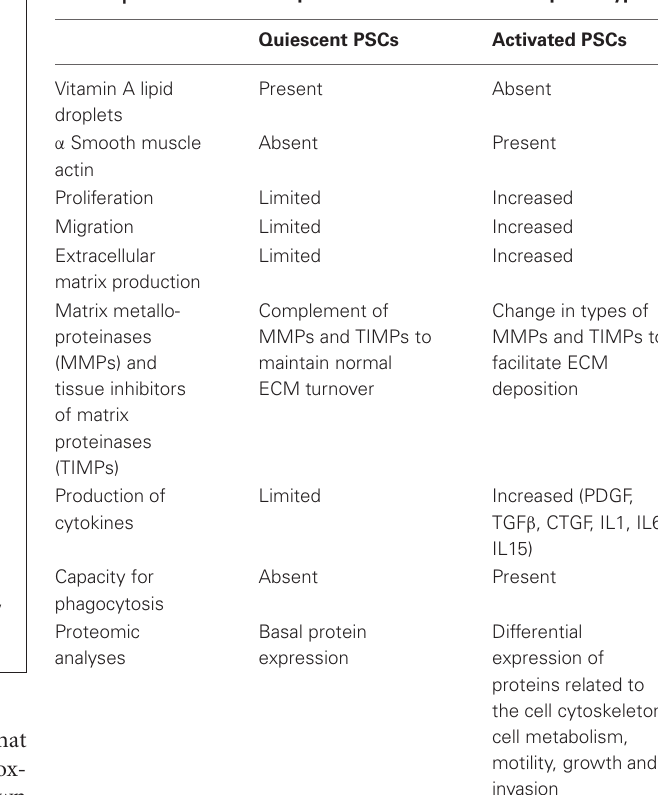
Table 1 | Characteristics of quiescent and activated PSC